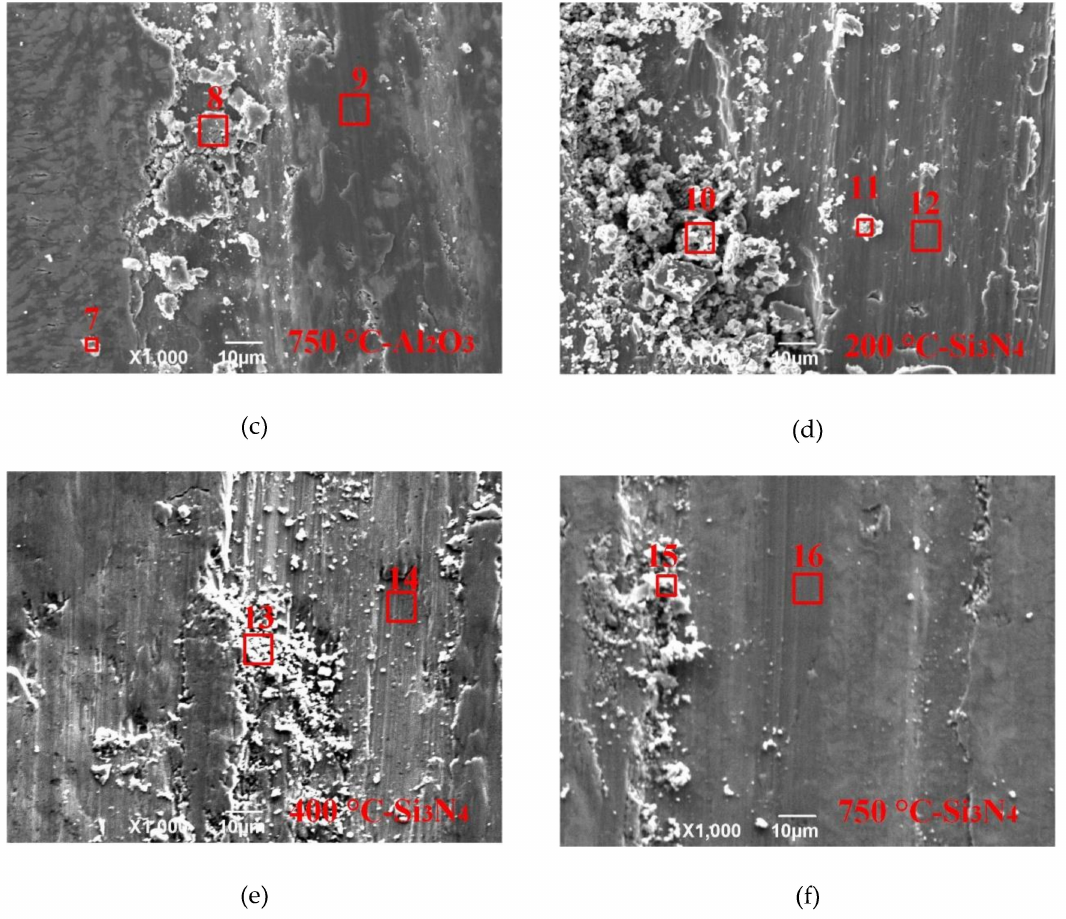
Figure 4. The worn surfaces of the alloy against Al 2 O 3 and Si 3 N 4 at different testing temperatures ( a ) Al 2 O 3 -